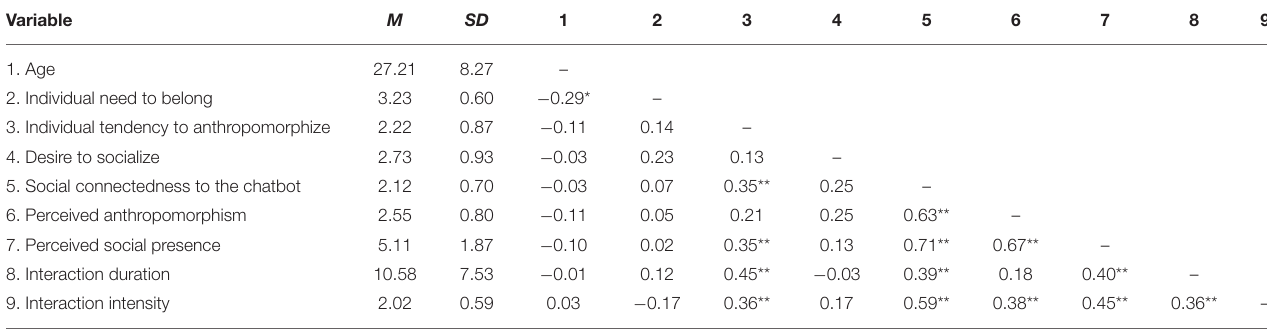
TABLE 2 | Means ( M ), standard deviations ( SD ), and Pearson correlations of variables used for hypotheses testing of the overall study sample. Variable M SD